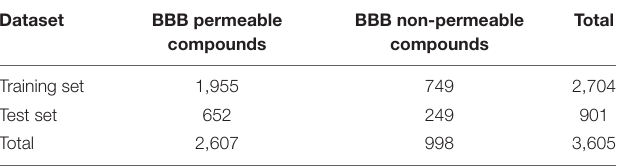
TABLE 2 | Distribution of the dataset in the training and test